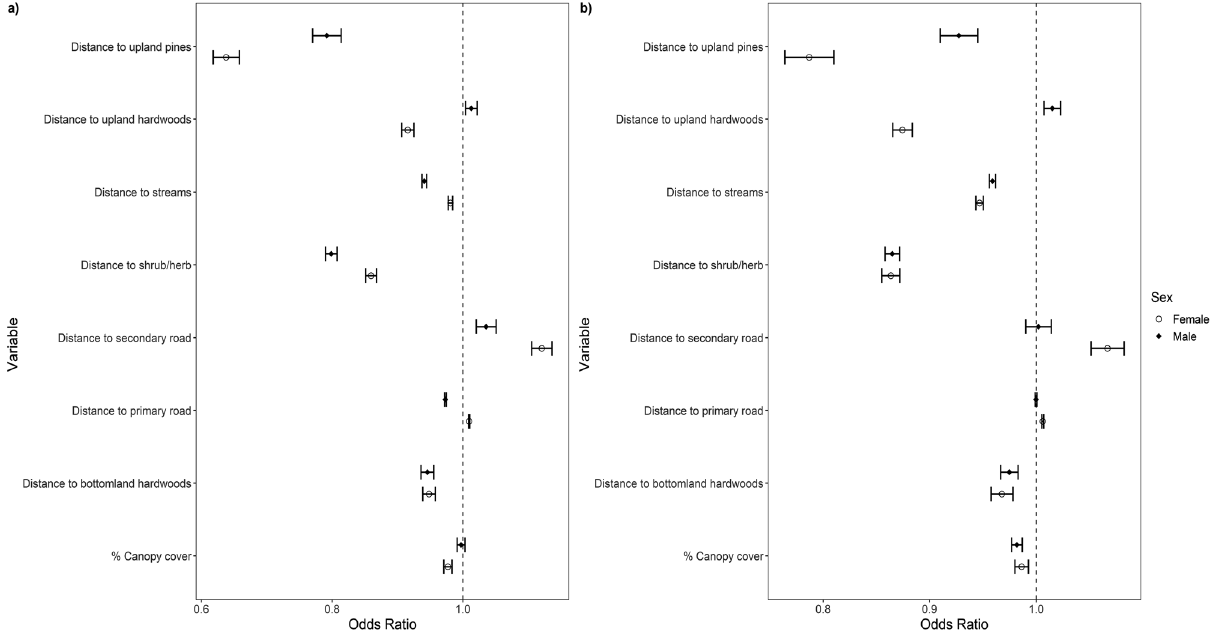
Figure 5. Predictive odds with 95% confidence intervals for second order selection (Johnson 1980) of female and male wild pigs ( Sus scrofa ) on the Savannah River Site in South Carolina during two distinct seasons based on forage availability, ( a ) low-forage availability (January–April) and ( b ) high-forage availability (May– December), for every 100 m increase for distance variables and every 10% increase for canopy cover. In cases where the confidence interval crosses 1, the variable is considered not